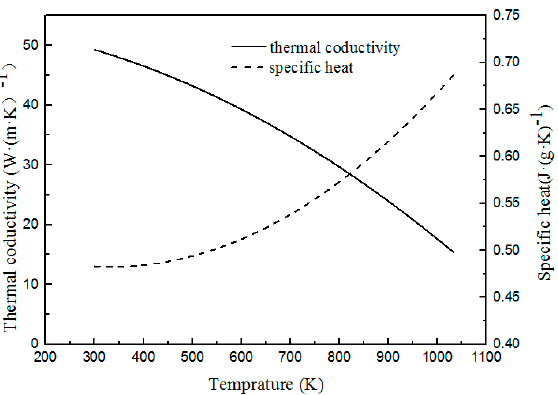
Figure 2. Thermal conductivity and specific heat of cast iron as a function of temperature.